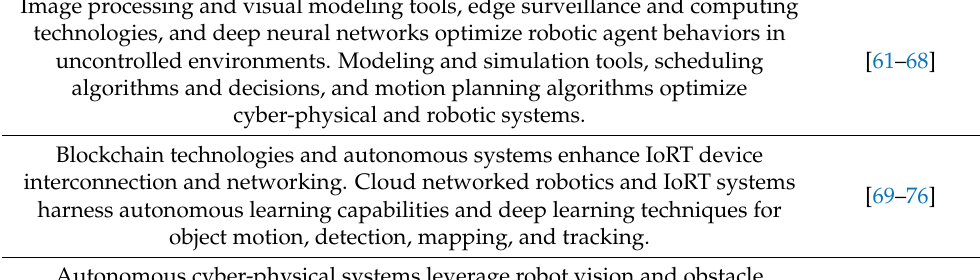
Table 2. Cont. Image processing and visual modeling tools, edge surveillance and computing technologies, and deep neural networks optimize robotic agent behaviors in uncontrolled environments. Modeling and simulation tools,